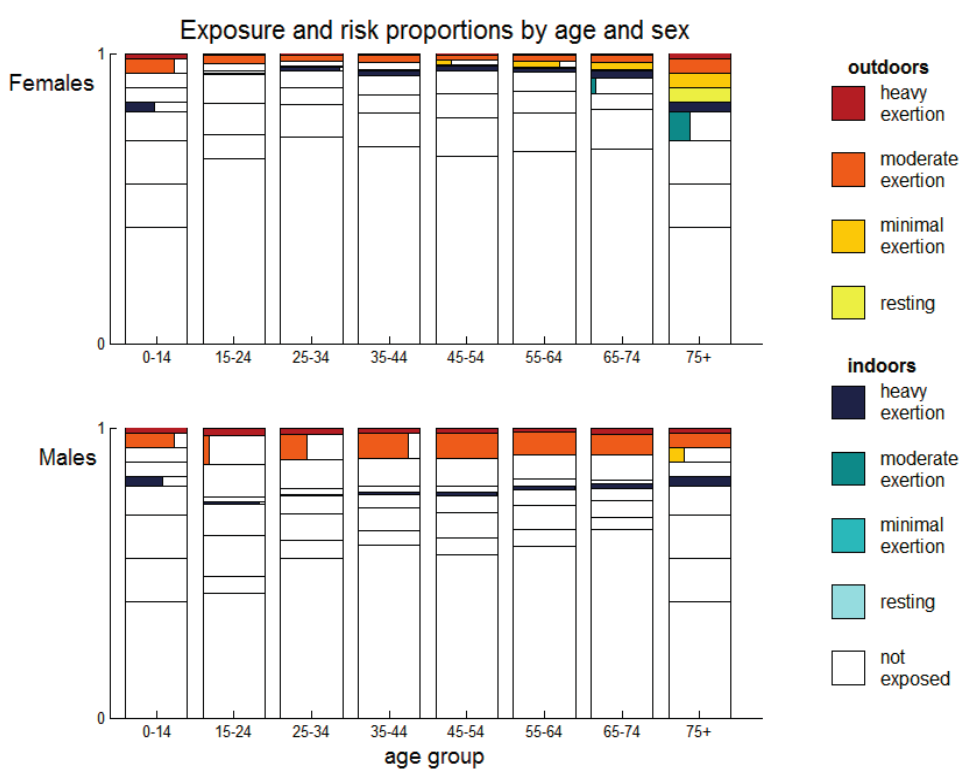
Figure 2. Exposure and risk proportions for each age group and sex at a temperature of 24.9 °C and 62% relative humidity. For each age-sex pair, we show a bar with horizontal lines dividing the bar into the nine rectangles that classify exposure and activity levels as in the legend. Within each rectangle, the proportion of the exposure group that is at risk is shown horizontally. Where the entire rectangle is filled (e.g., males aged 65–74 outdoors moderate exertion) this indicates that the entire exposure category is at risk for that age and sex combination. Where the rectangle is partly filled (e.g., males aged 35–44 outdoors moderate exertion) this indicates that only some of that exposure category is at risk, and that body shape (height and weight) also influences risk in this group under these weather